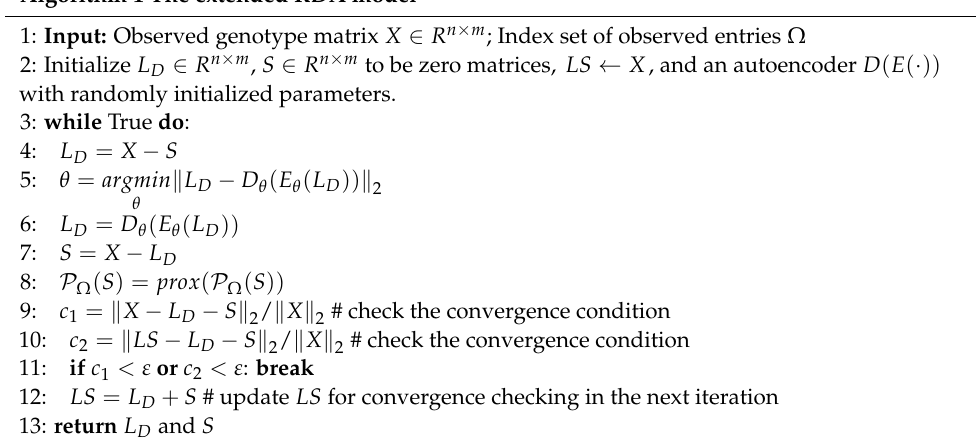
Algorithm 1 The extended RDA